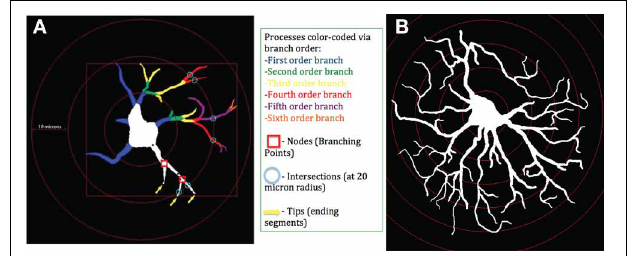
FIGURE 3 | Schematic of astrocytes and parameters measured. Astrocytes were identified using GFAP antibody. Images were imported into Neurolucida and examined in Neurolucida explorer. At left, an astrocyte from a control macaque (A) . At right, an astrocyte from a macaque infected with B. melitensis (B) . Each concentric ring represents 10 μ